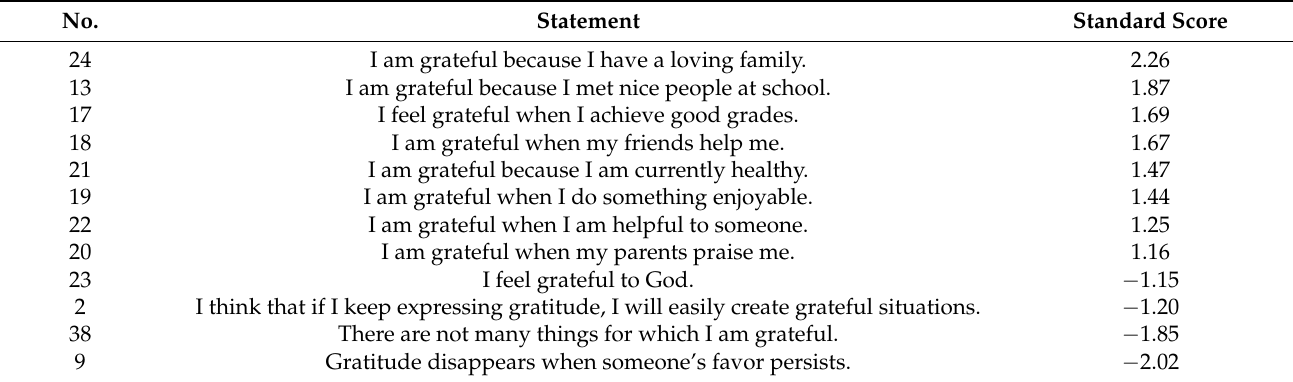
Table 9. Statements and standard scores (at least ± 1.00) of Type